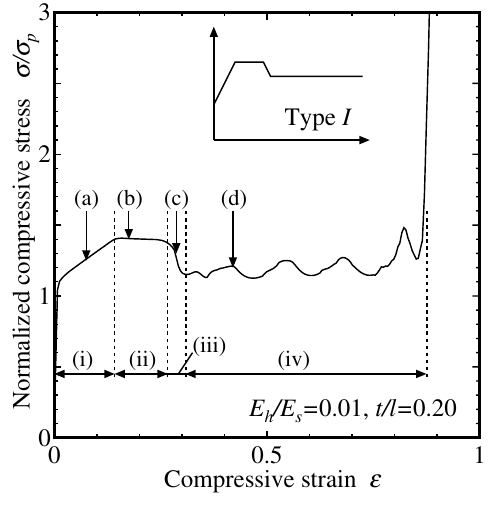
Figure 5. Typical stress-strain response of Type I.